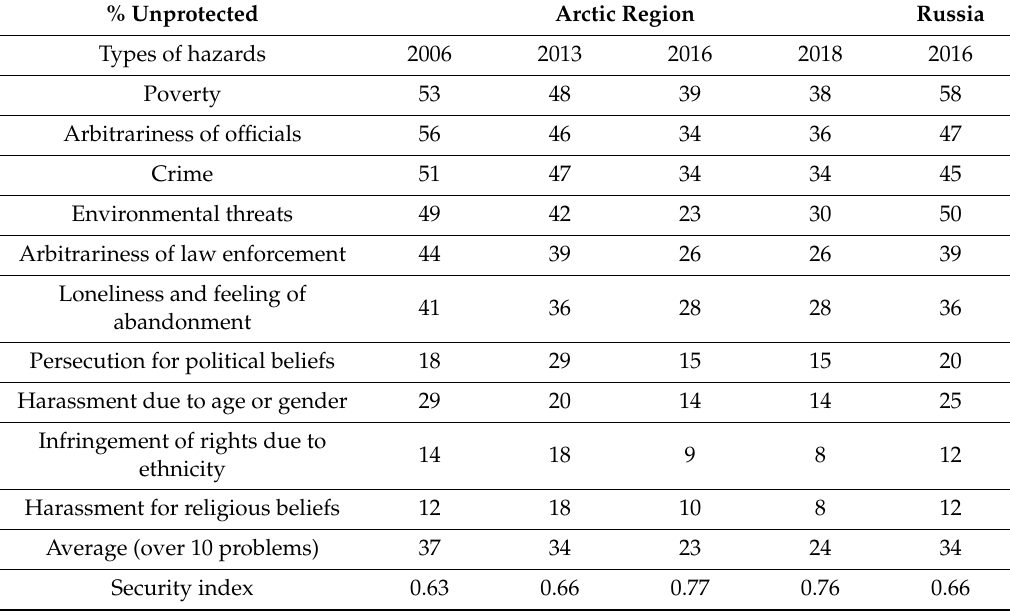
Table 1. Dynamics of the level of vulnerability (in %) and index of security for residents of the Arctic region of the Russian Federation during the period 2006–2018 and Russia as a whole (for reference in